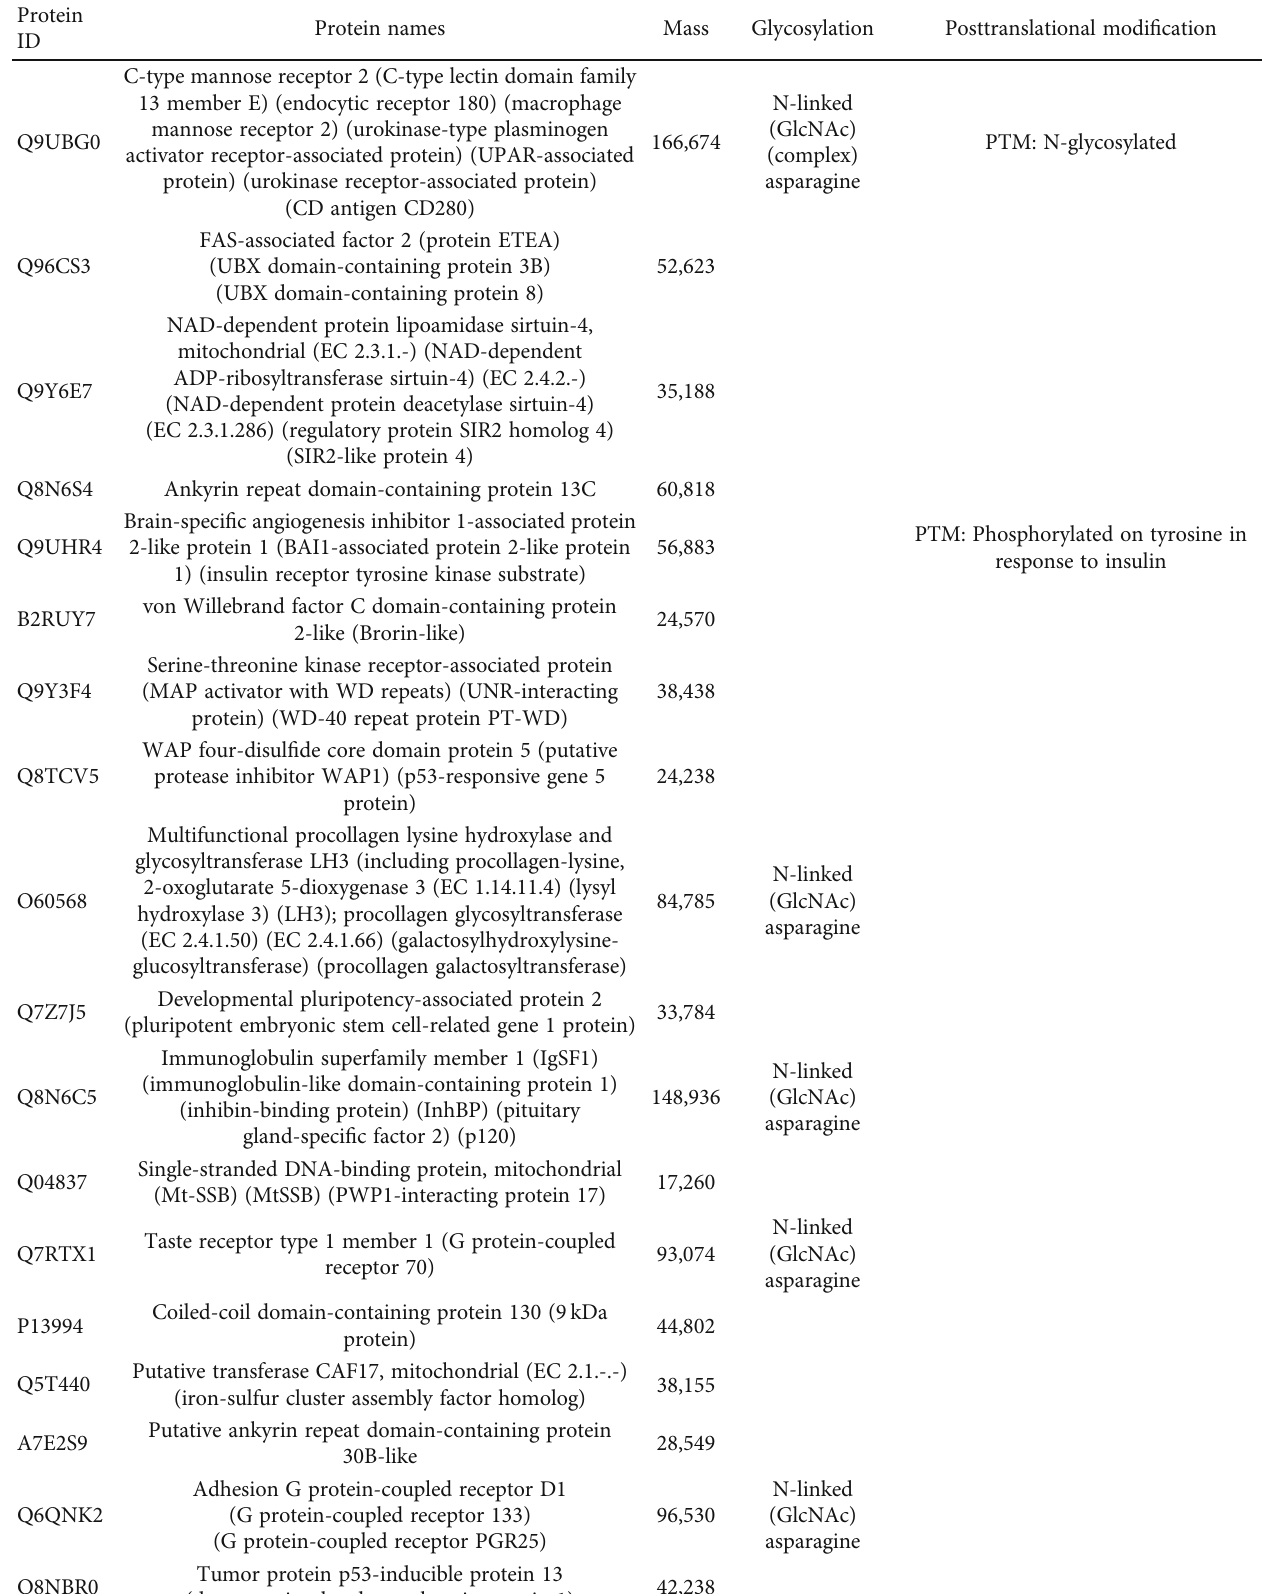
Table 4: Downregulated glycoproteins in the serum of the AD group (identi fi ed proteins from the UniProt Homo sapiens database). Protein Protein names Mass Glycosylation Posttranslational modi fi ID